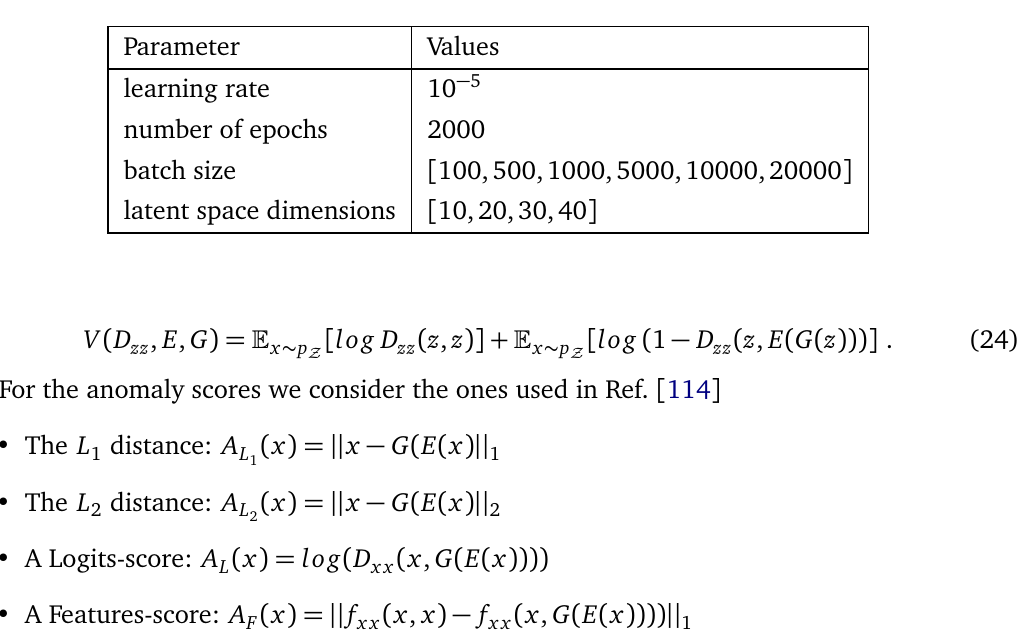
Table 21: ALAD model